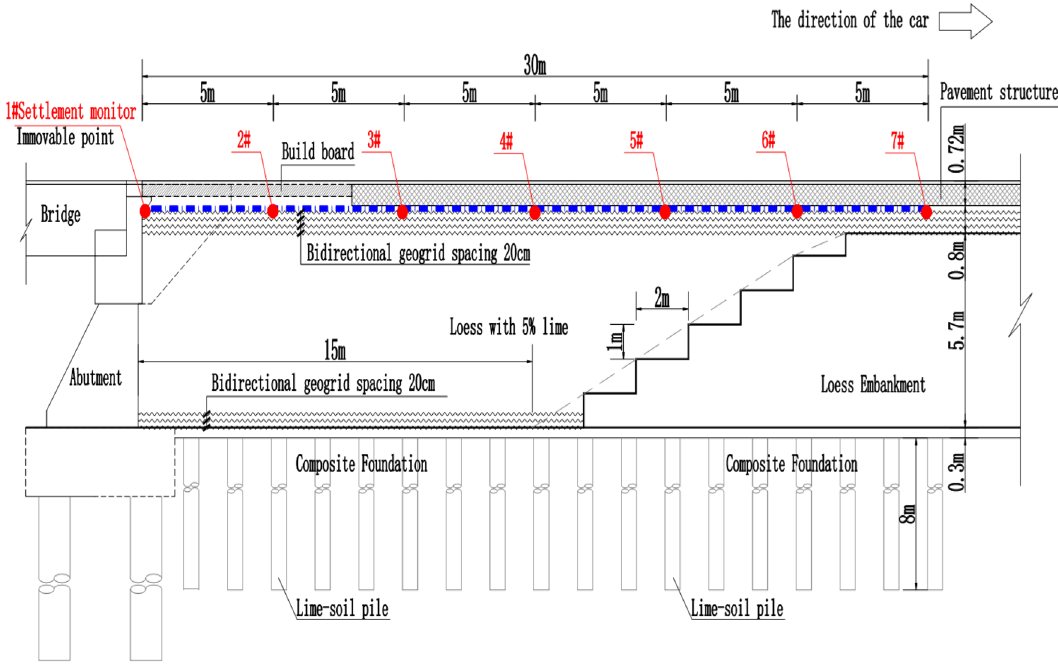
Figure 1. Longitudinal section of the transition section.